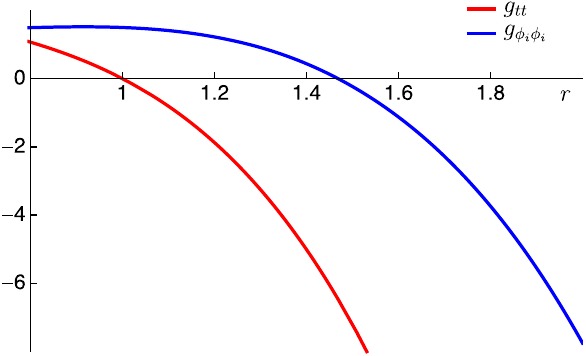
Fig. 1 The metric components g tt and g φ with parameters (cid:2) = 1, i φ i M = 0 . 5, a i = 1, z = 2 and d = 5. The vertical axis signals the event horizon radius r H . From the event horizon to the intersection of the red curve with the r-axis we have the ergosphere . From the intersection of the blue curve with the r-axis to infinity we have closed timelike curves